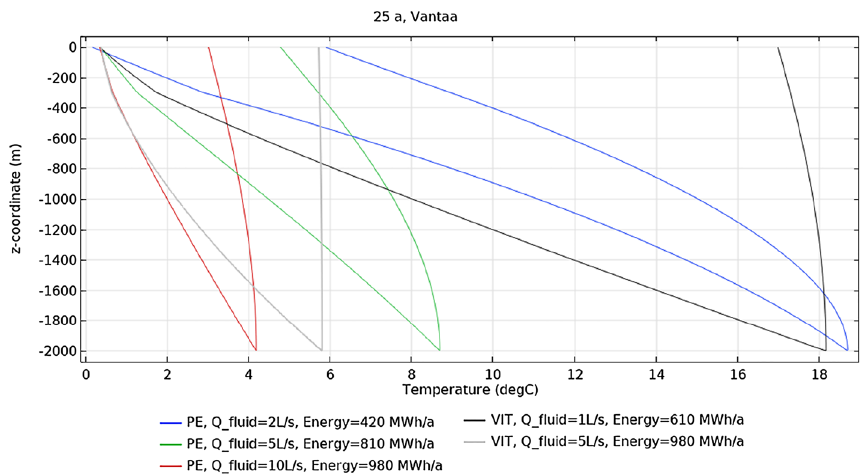
Fig. 4 Vertical temperature profiles of a 2000-m BHE with a VIT or HDPE pipe collector and different volumetric flow